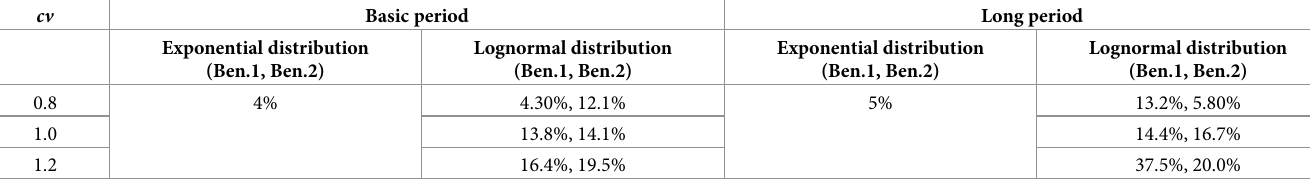
Table 9. Expected profit improvement compared to two benchmark